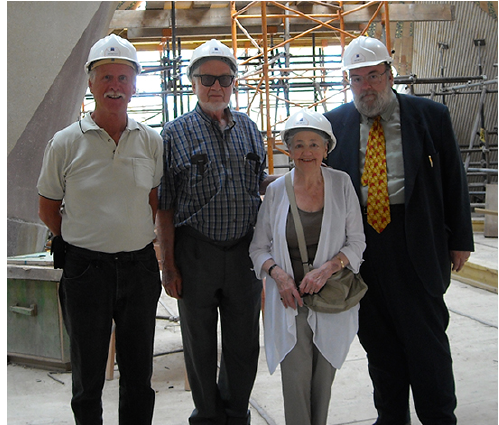
Figure 2: From left to right: Roger Nelsen, Bert Schweizer, his wife Judie, and Claudi Alsina in 2009 during a visit to the con- struction of the Sagrada Familia in Barcelona,